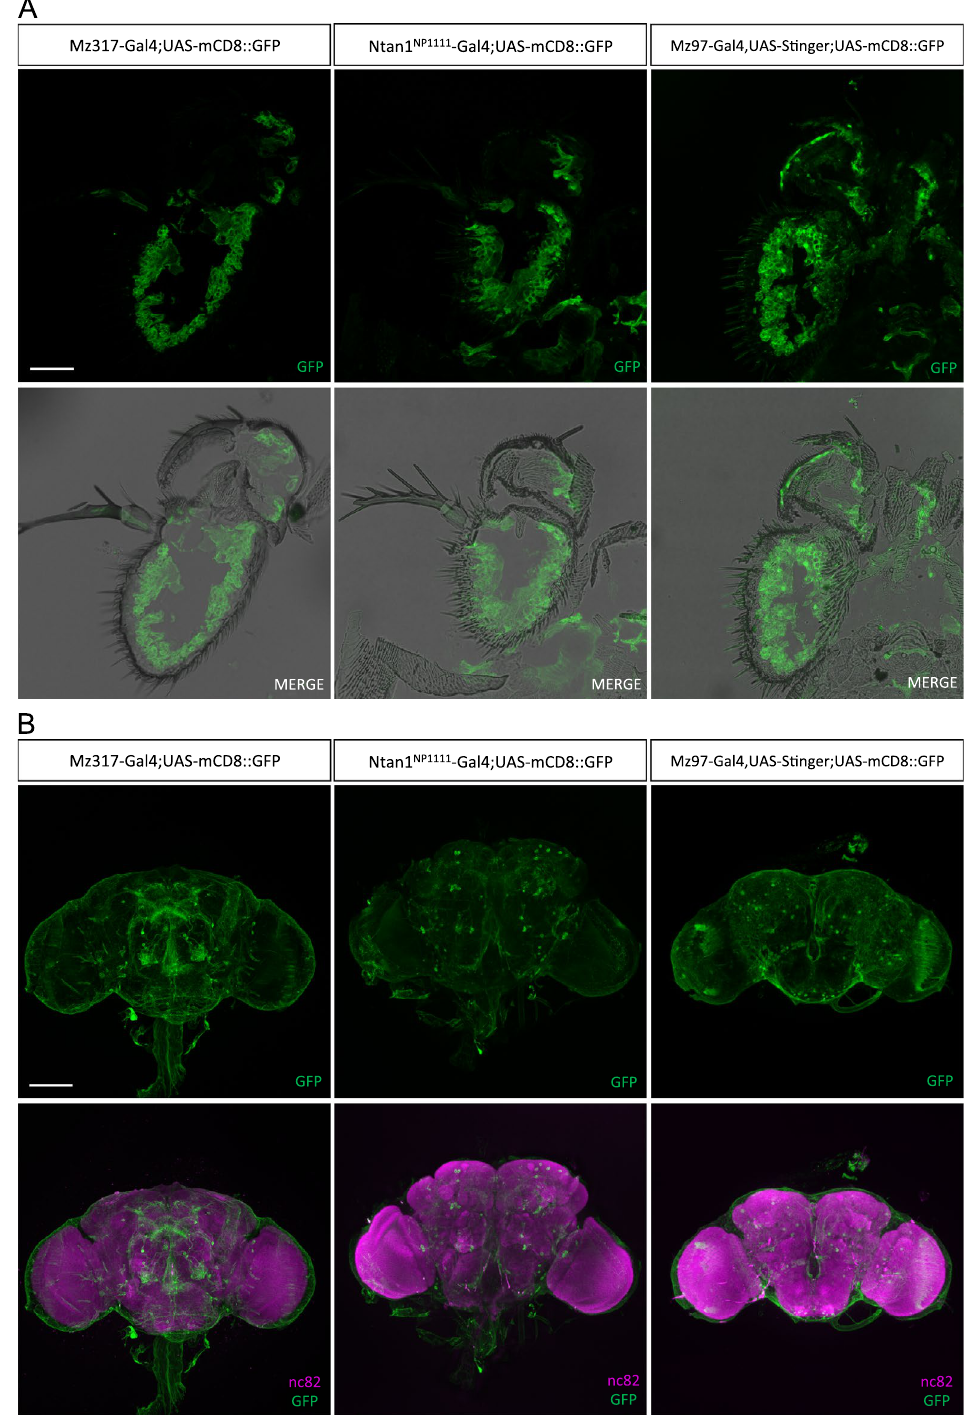
Figure 4. Analysis of GFP expression in different Ntan1 -related Gal4 lines in Drosophila melanogaster . ( A ) Immunohistochemistry on antennal cryosections (14 µm) with anti-GFP antibody (green) on the